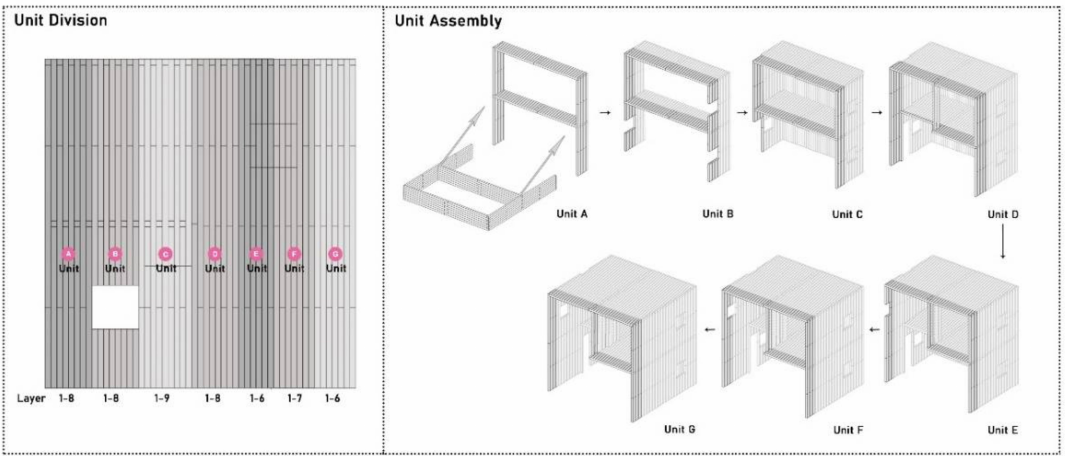
Figure 4. Unit division and unit